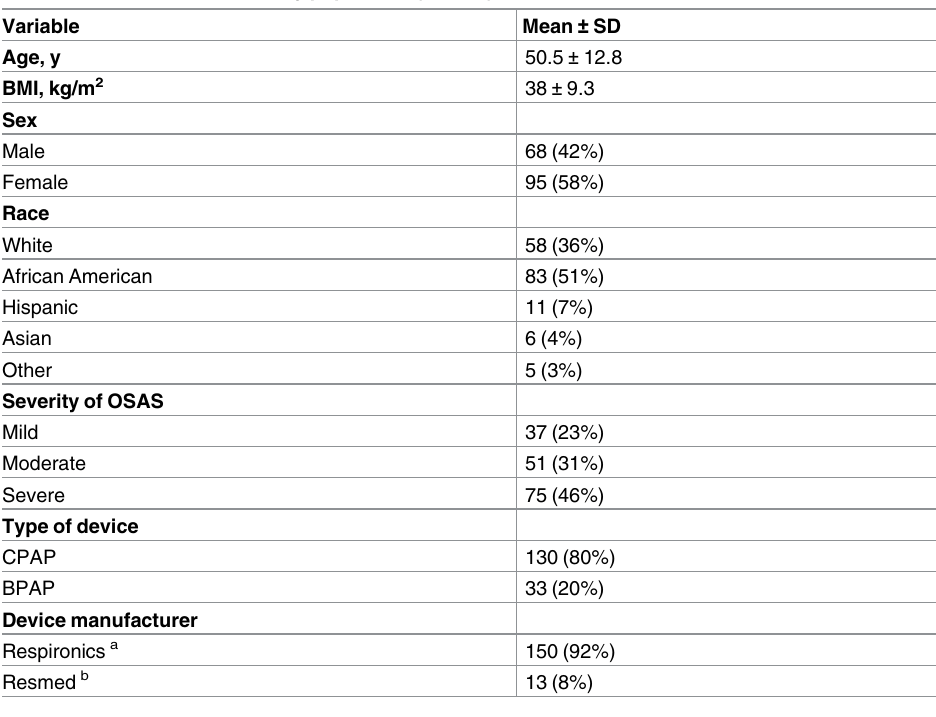
Table 1. Characteristics of study population (n =